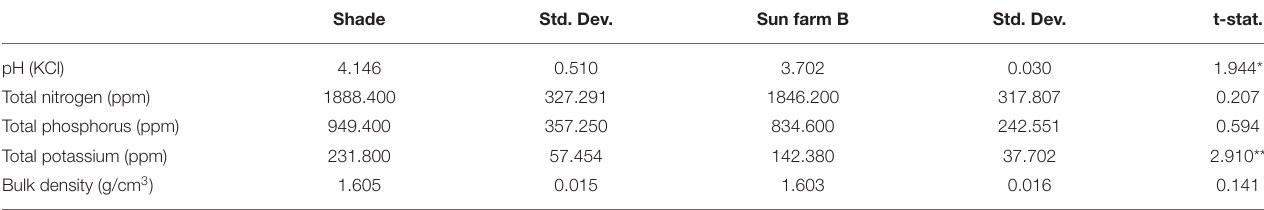
TABLE 2 | T -test of soil analysis in shade farm vs. sun farm